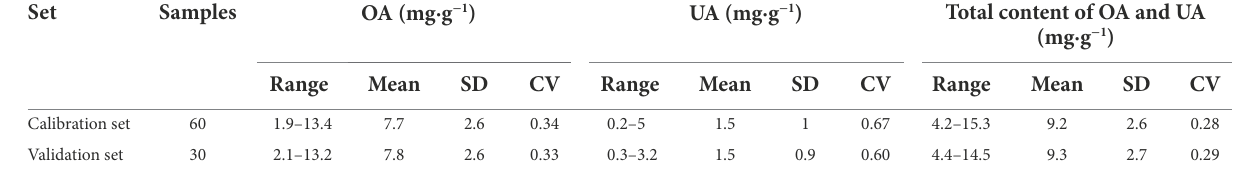
Calibration set Validation